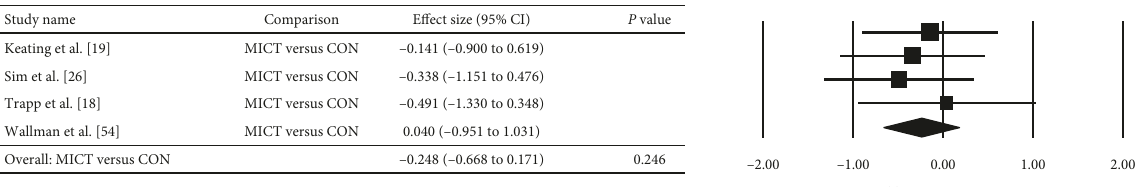
Figure 7: Effect of MICT versus CON on bodyweight. MICT: moderate-intensity continuous training, CON: control, and CI: confidence